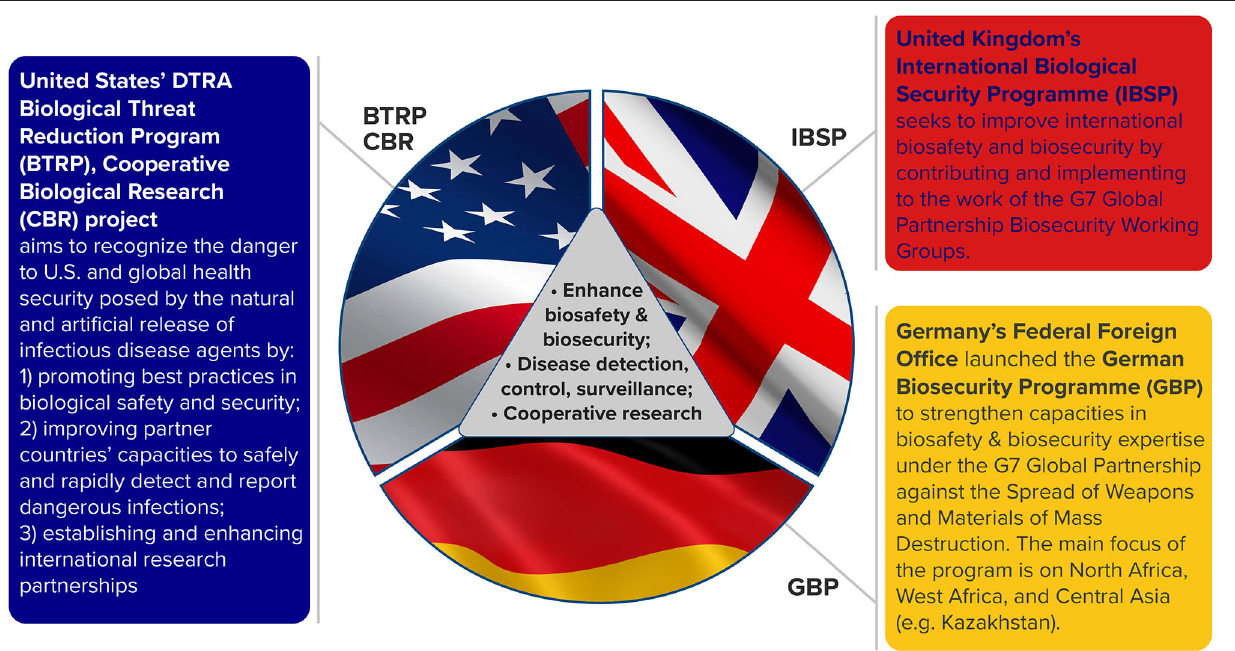
FIGURE 1 | Common aims and objectives for related cooperative research programs in Kazakhstan. These national programs also adhere to international frameworks for biological threat reduction: Biological Weapons Convention (BWC, Article X), World Health Organization International Health Regulations (IHR, 2005),